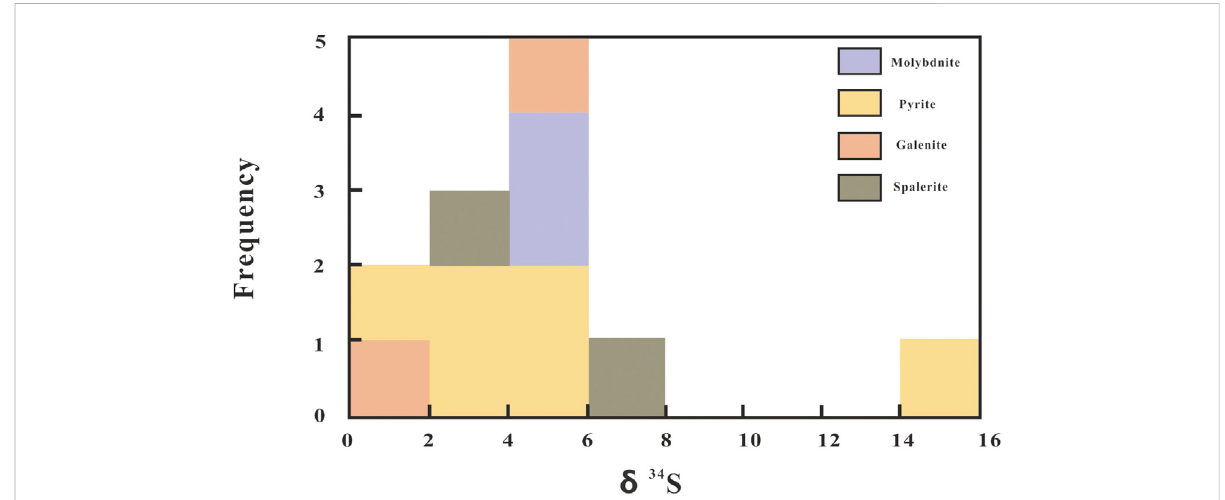
FIGURE 11 Histogram of sulfur isotope values of sul fi de minerals in the Shibaogou Mo – Pb – Zn deposit.